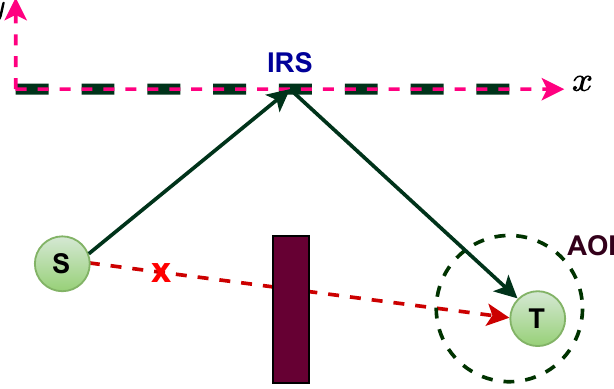
Figure 11. IRS-assisted Localization